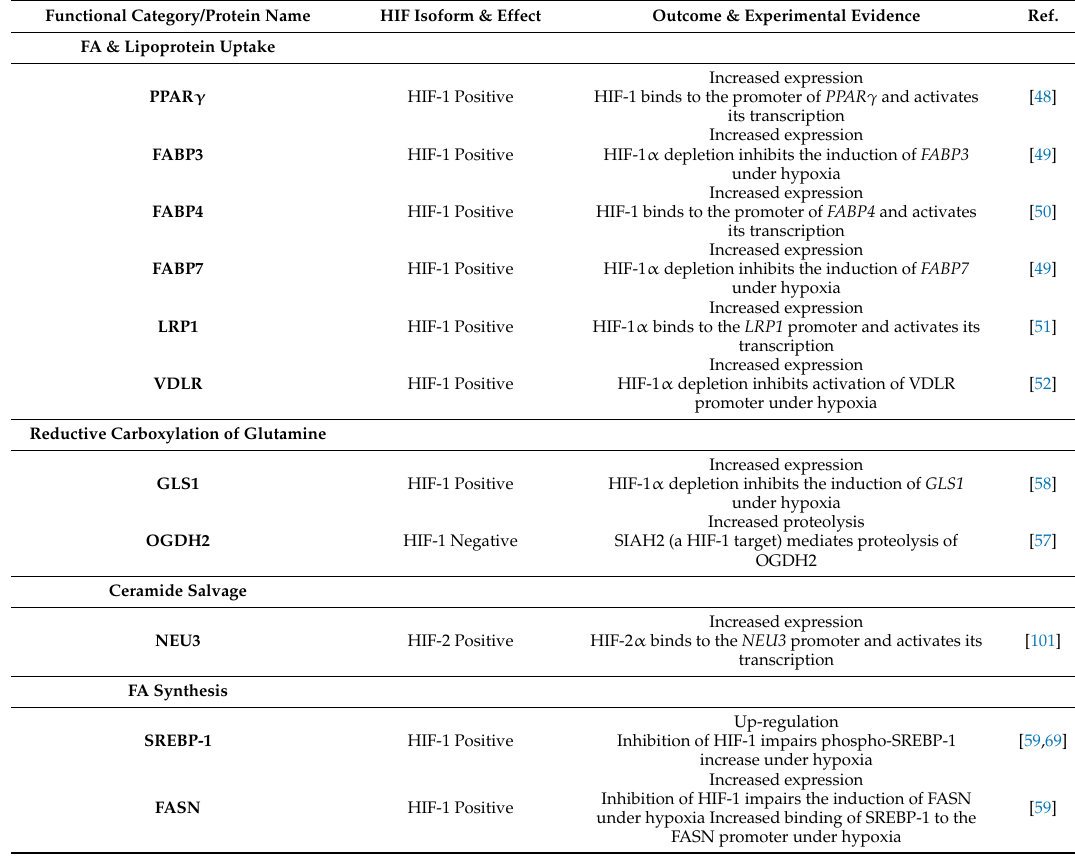
Table 1. Representative HIF direct or indirect target genes that mediate reprogramming of lipid metabolism under